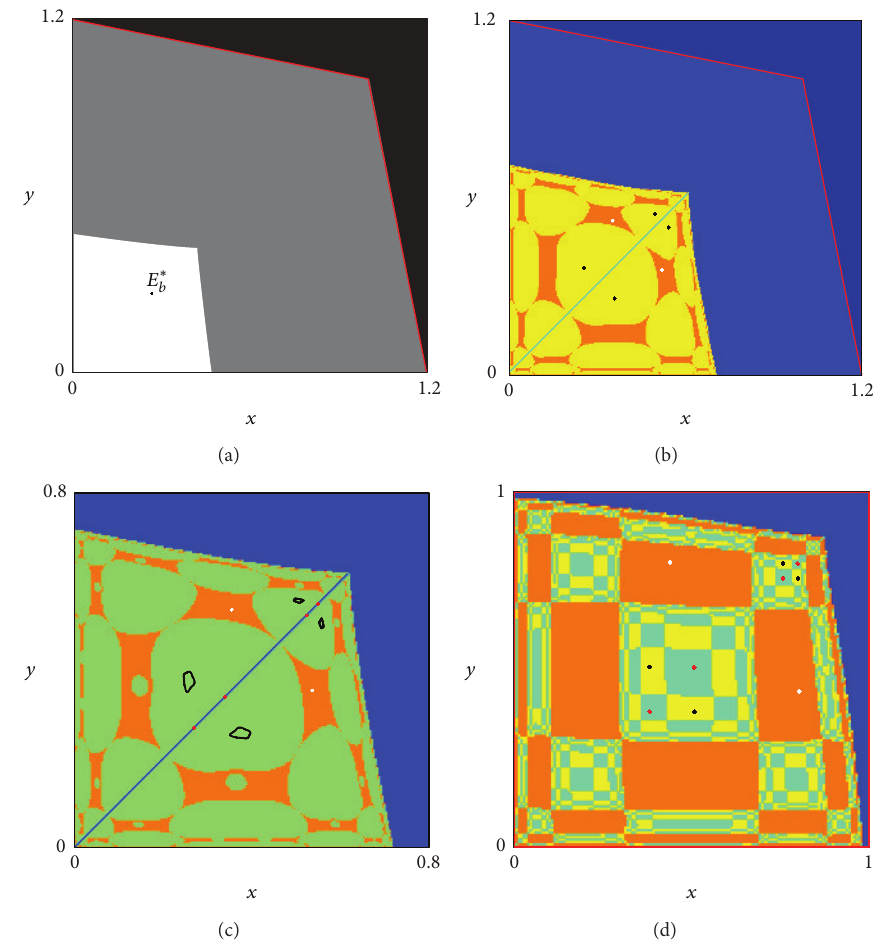
Figure 5: Parameter values: 𝛼 = 1.5 and 𝑤 = 0.5 . (a) The white region represents the basin of 𝐸 ∗ 𝑏 for 𝑏 = 5.1 and 𝑑 = −0.2 . (b) A 4-period cycle together with a 2 -period cycle coexists with the attractor 𝐴 belonging to the diagonal (a two-period cycle) for 𝑏 = 2.4 and 𝑑 = −0.2 . (c) For 𝑏 = 2.3 , a 4 -piece quasi-periodic attractor has been created, 𝑑 = −0.2 . (d) A particular scenario is presented for 𝑏 = 0.2 in the case of independent products 𝑑 = 0